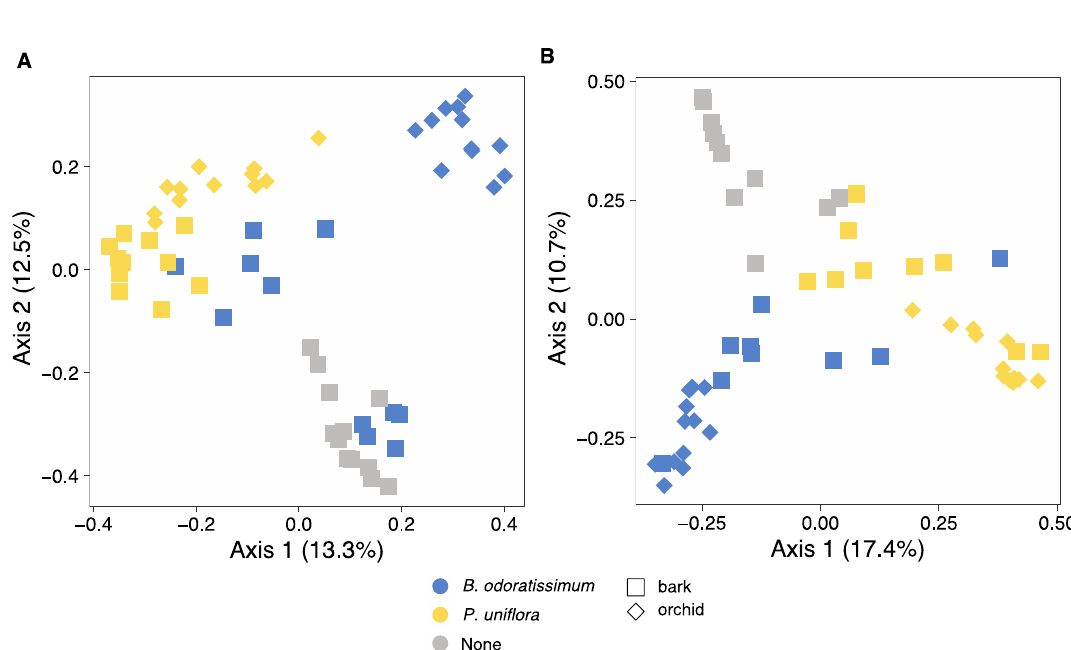
Figure 4. Total ( A ) and orchid-associated ( B ) fungal community structure of B. odoratissimum and P. uniflora and of the bark from the host tree where the orchids were